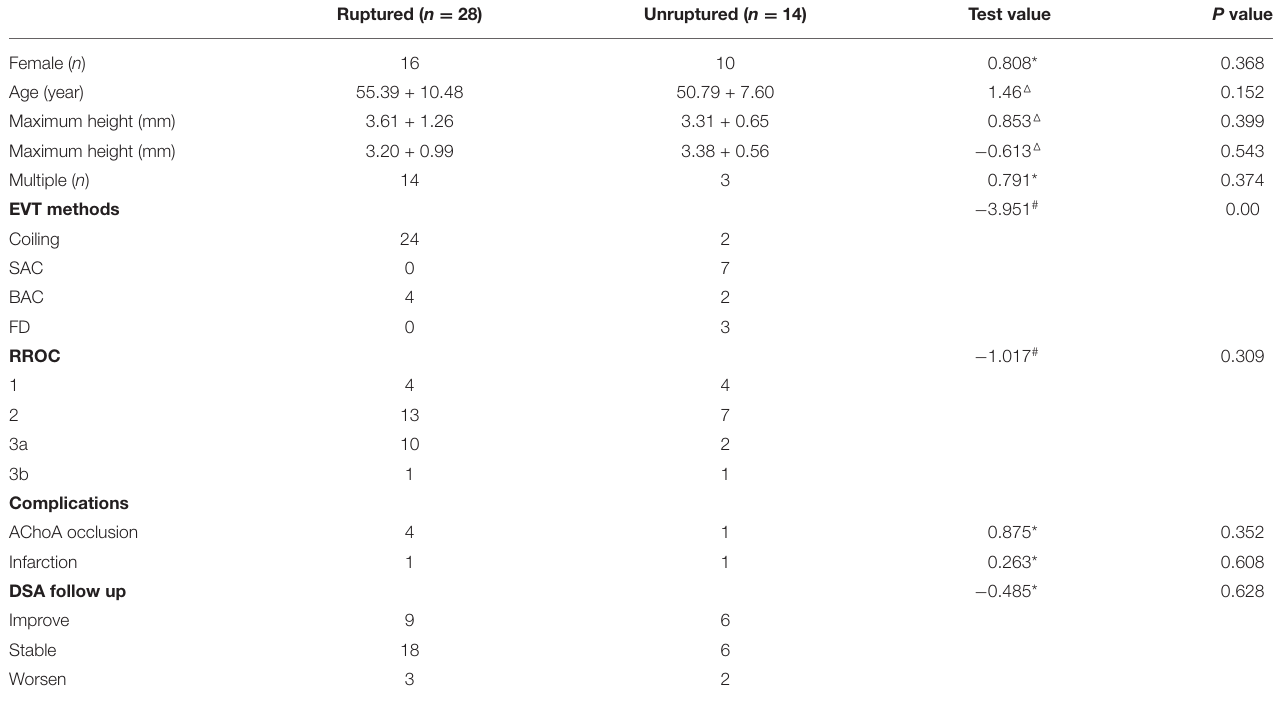
TABLE 2 | The characteristics of ruptured and unruptured aneurysms. Ruptured ( n = 28) Unruptured ( n = 14) Test value